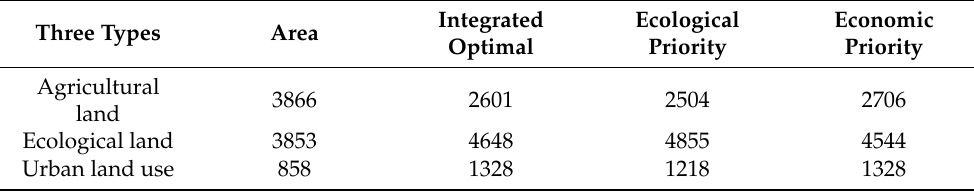
Integrated Ecological Economic Optimal Priority Priority 3866 2601